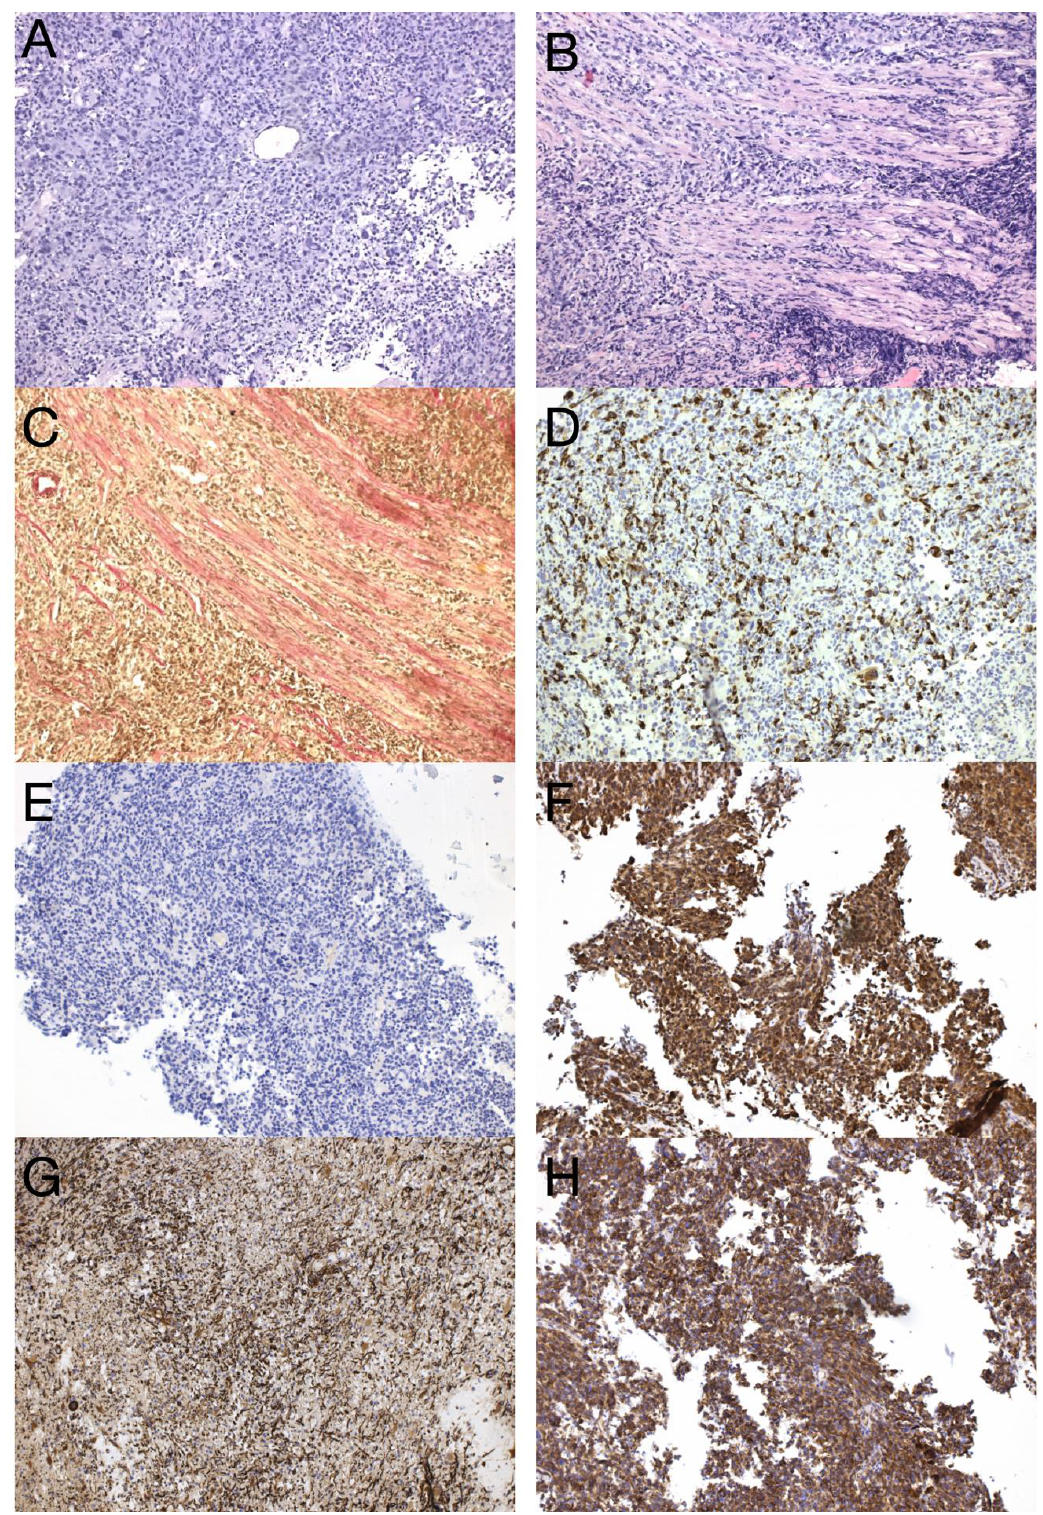
Figure 8. Histological and immunohistochemical analysis of GBM metastasis. Spinal metastasis— hypercellular high-grade diffuse glioma ( A ) infiltrating dura mater and spinal cord ( B ), verified by special staining—van Gieson, which stains collagen fibers red ( C ). Immunohistochemical expression of GFAP in tumor cells ( D ), synaptophysin ( E ), neuron-specific enolase ( F ), nestin ( G ), and beta- catenin displaying only membranous expression ( H ) (original magnification 100 ×